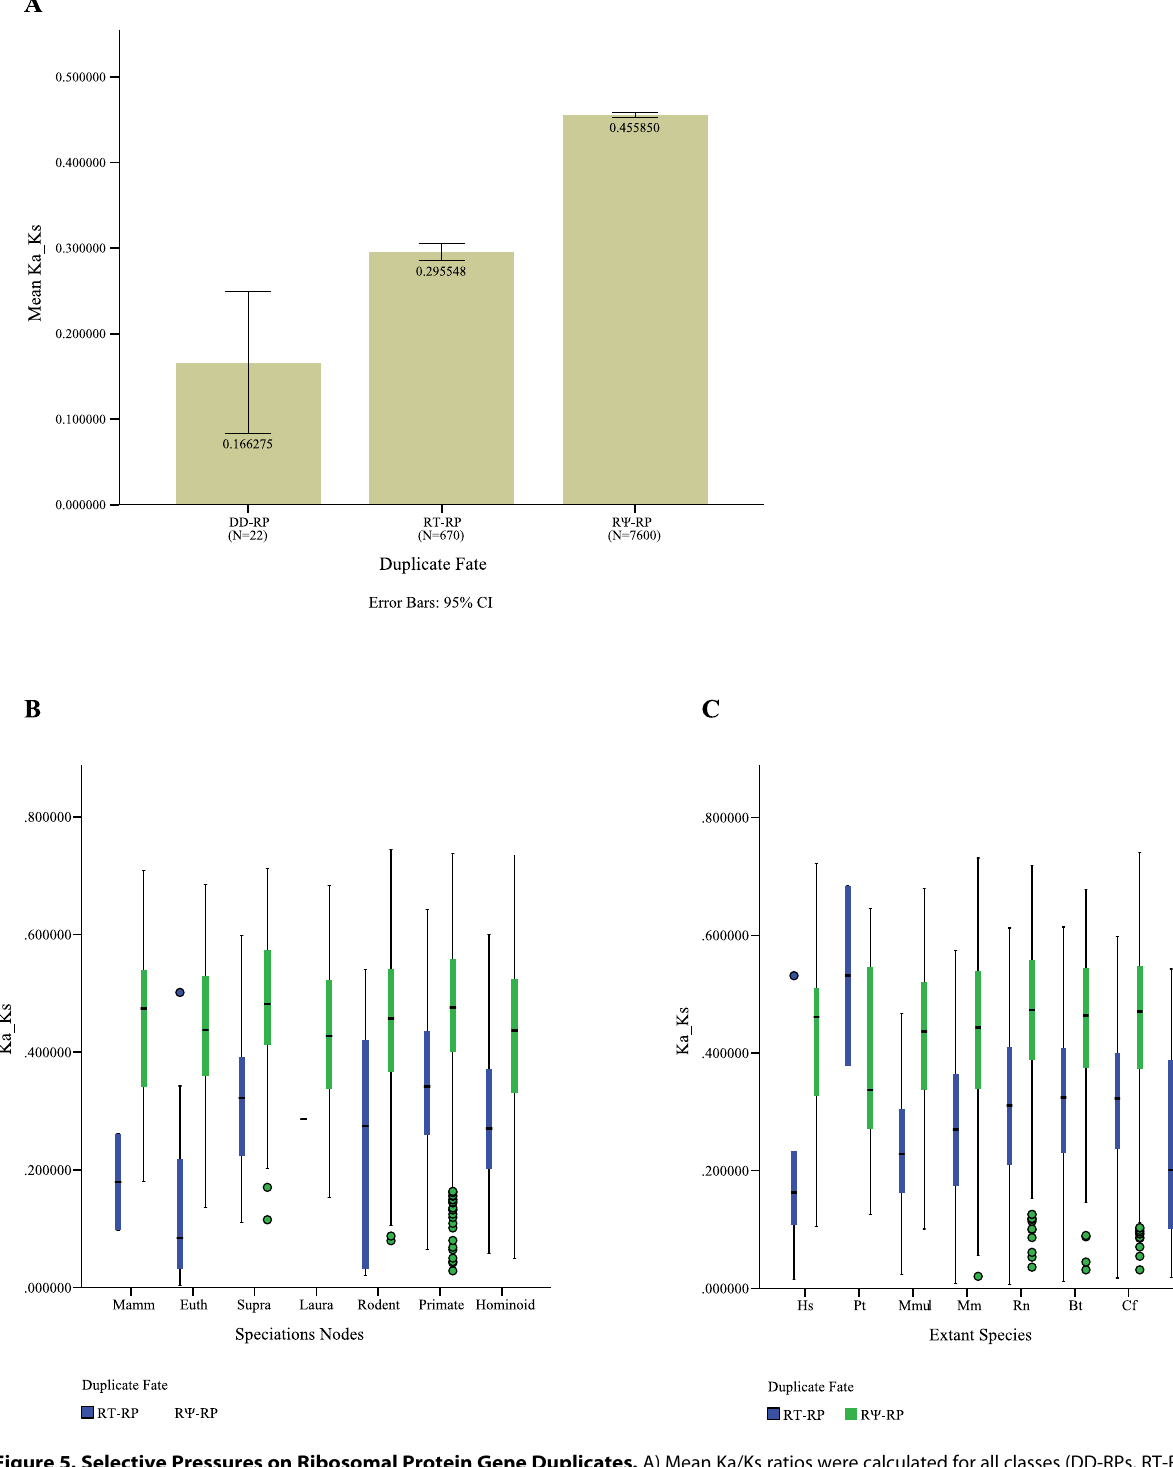
Figure 5. Selective Pressures on Ribosomal Protein Gene Duplicates. A) Mean Ka/Ks ratios were calculated for all classes (DD-RPs, RT-RPs and R Y -RPs) of RP gene duplicates using the Nei Gojobori method. Results were then filtered based on p-values ( , 0.1) and the fraction of the parental gene represented by each duplicate ( . 65%). Error bars represent 95% confidence interval. B) Box and whisker plots for RT-RPs (blue) and R Y -RPs (green) were generated for inner speciation nodes and C) Extant Species. DD-RPs were not included in the analyses due to small sample size (N=3).